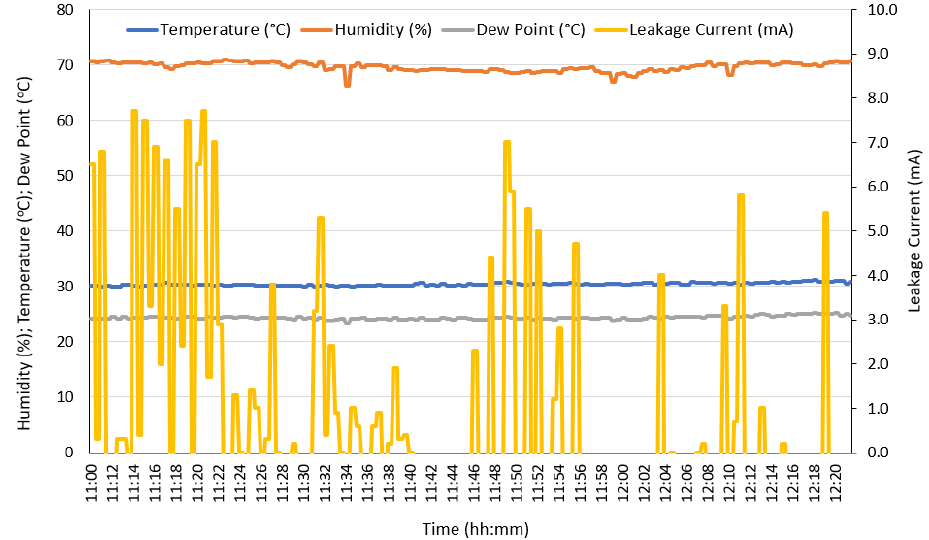
Figure 14. The data acquired in the test chamber and transmitted via GPRS to the laboratory server over a period of 1 h 20 min.